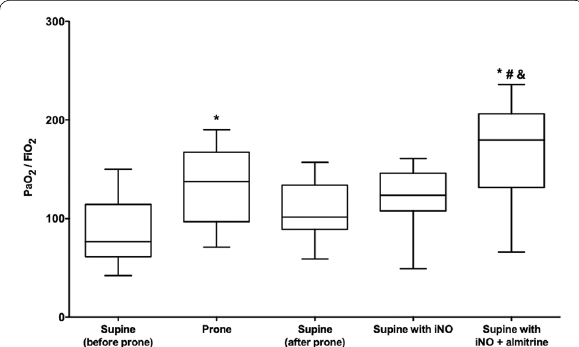
Fig. 1 Box and whiskers plots of the change in the ratio of oxygen partial pressure (PaO 2 ) to fraction of inspired oxygen (FiO 2 ) in arterial blood in prone position and supine position, before and after administering inhaled nitric oxide (iNO) and almitrine in patients with severe acute respiratory distress syndrome secondary to coronavirus disease 2019. *, # , and & denote a p value < 0.05 for paired Wilcoxon (with Benjamini–Hochberg correction) following Friedman test, as compared to supine (before prone), supine (after prone), and supine with iNO,